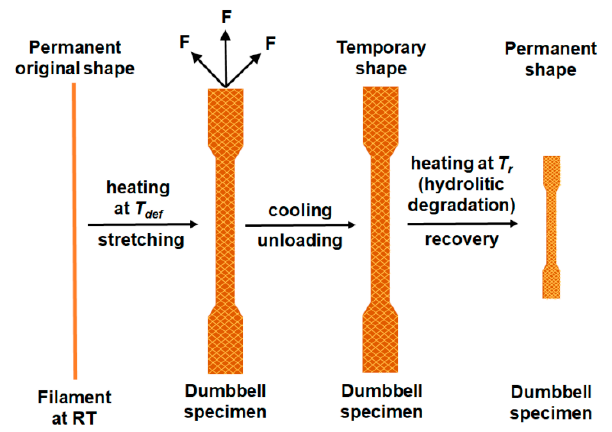
Figure 8. Shrinkage effect considered as thermal retraction; T def – deformation temperature, T r – temperature of retraction